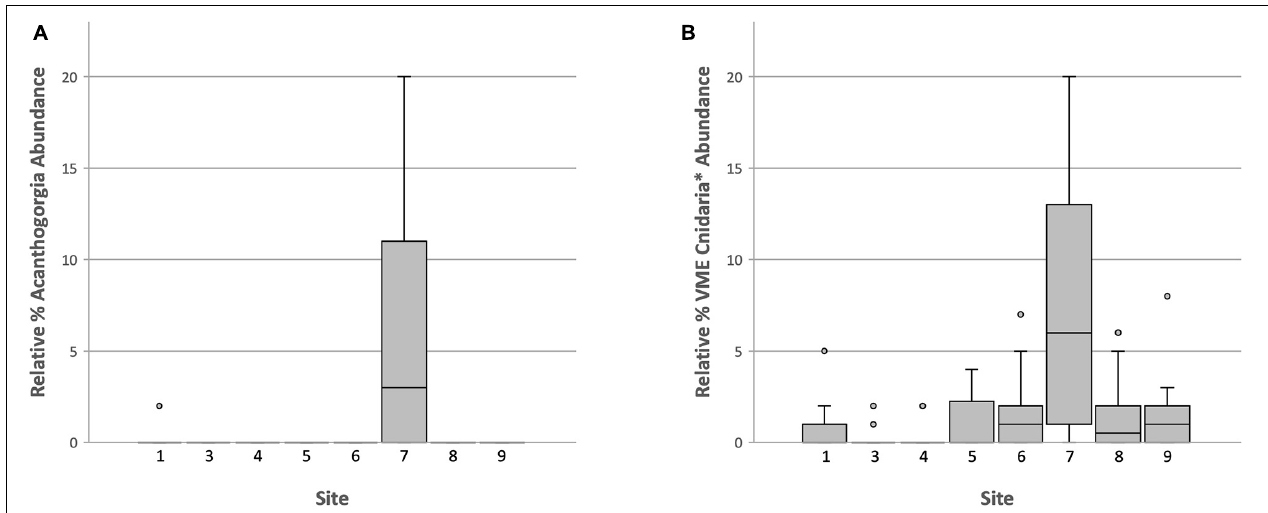
FIGURE 10 | Boxplot of relative abundance data for: (A) The coral, Acanthogorgia and (B) Cnidaria VME taxa, excluding hydroids and primnoids as these cnidarian taxa are found to be positively correlated with sponges (see Table 3 ).